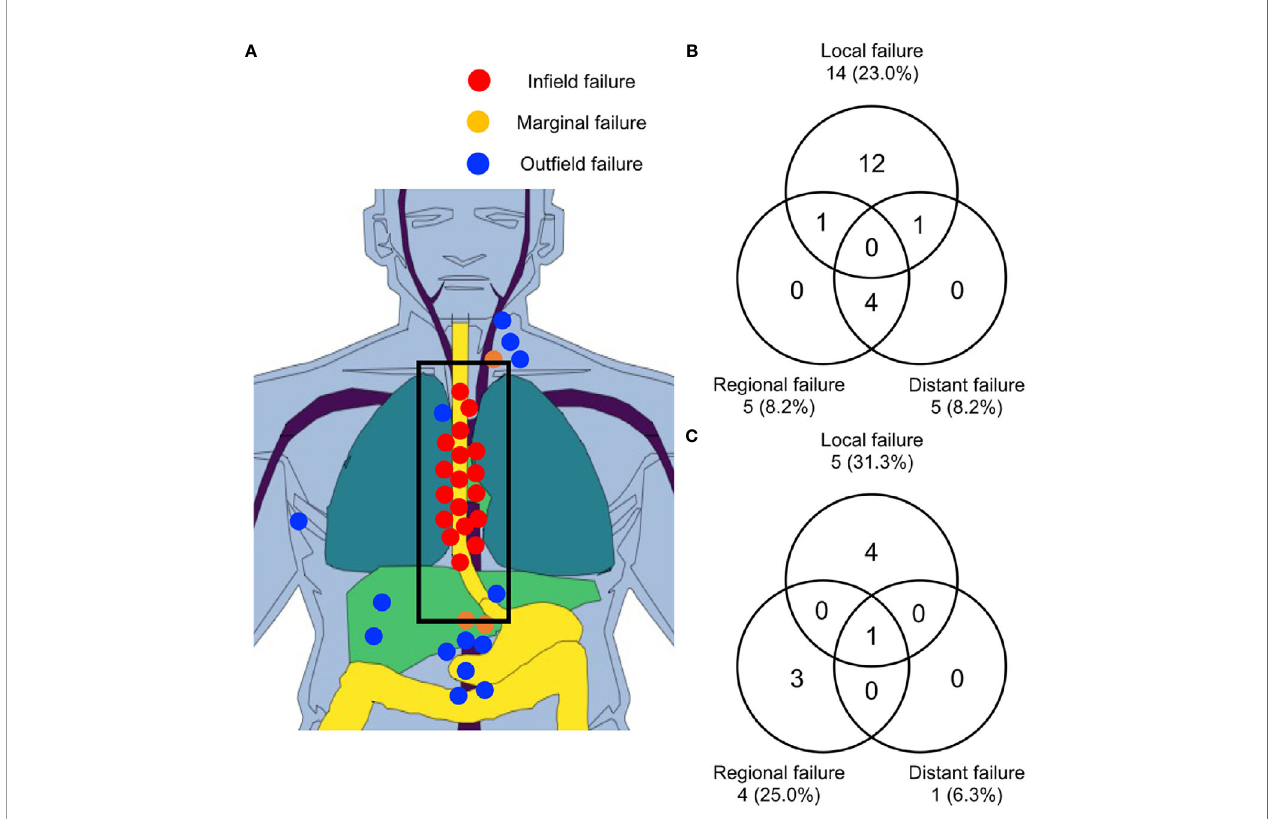
FIGURE 3 | Failure sites according to the RT fi eld in all patients (A) . Patterns of treatment failure for patients with T1 (B) and T2 – 3 (C) cancer. RT,